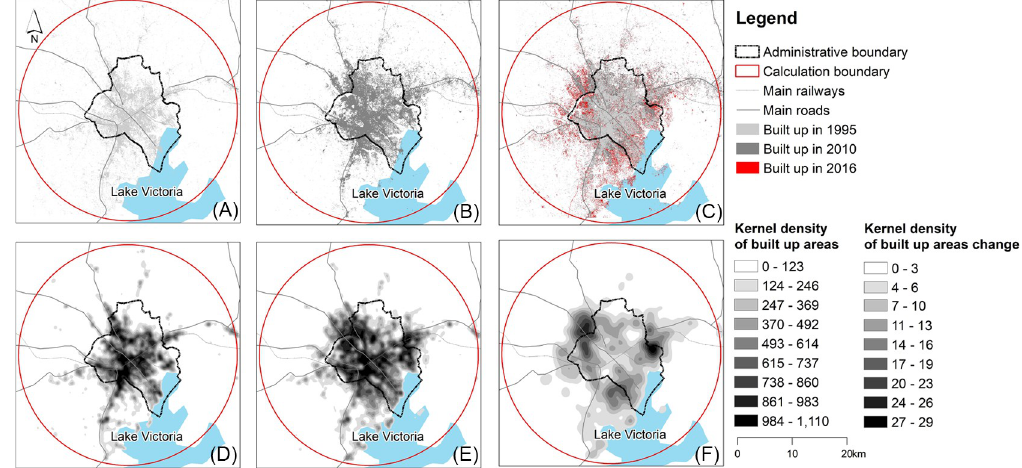
Fig 2. The built-up distribution of Kampala in 1995 (A), 2010 (B) and 2016 (C); the built-up kernel density of Kampala in 1995 (D), 2016 (E) and the new built-up area in 2016 compared to 1995 (F) significantly or show strong evidence of infilling urbanisation developments. The classification method is equal interval, with nine classes and a white to black color scheme to point towards high (black) and low (white) point pattern densities. The highest point pattern densities represent the hotspots of city growth from 1995 to 2016, defined as compact growth within the